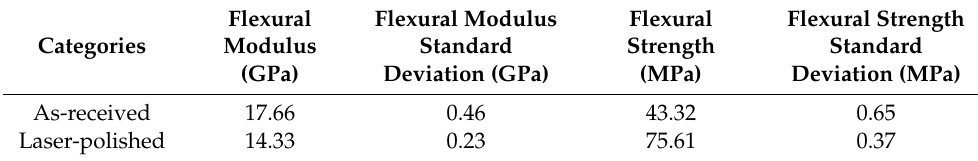
Table 7. Flexural properties and standard